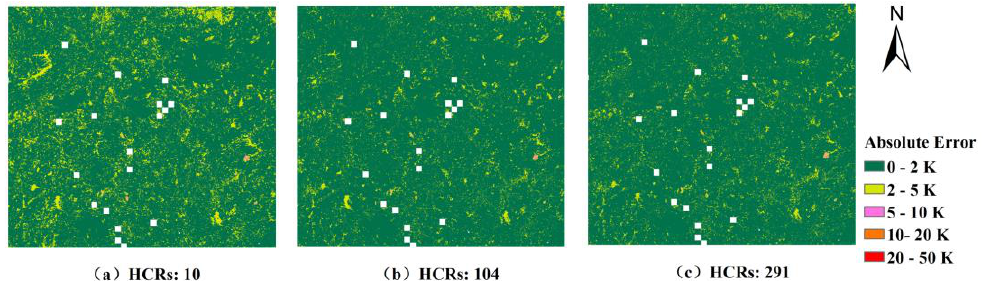
Figure 9. Comparison of the absolute error distribution of model fusion results based on different numbers of HCRs on 20 November 2001.